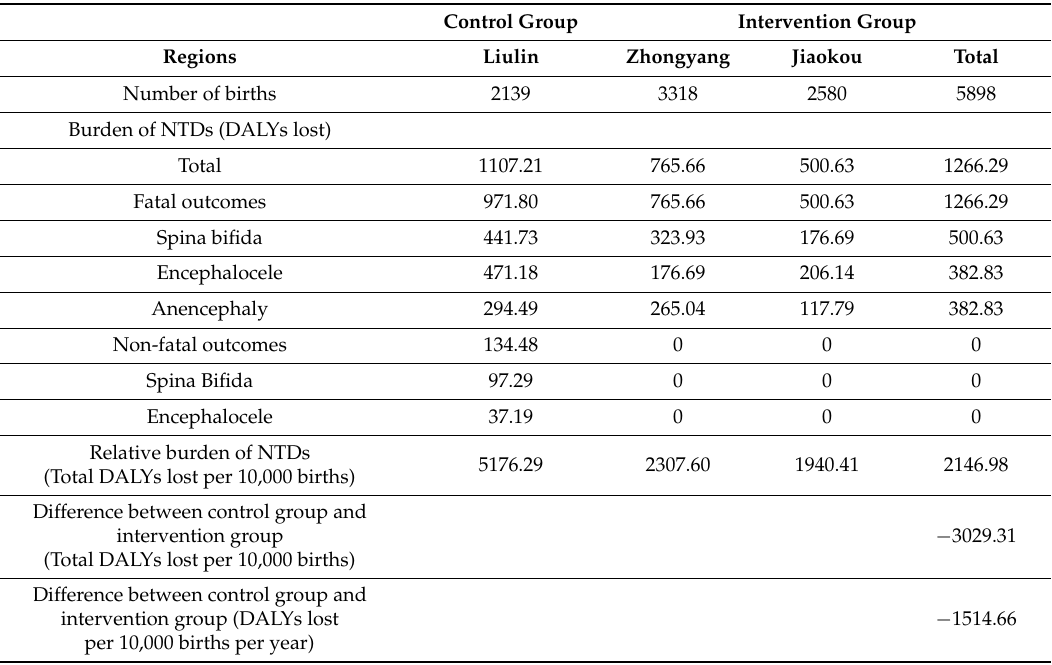
Table 5. Effects of fortified flour on the burden of